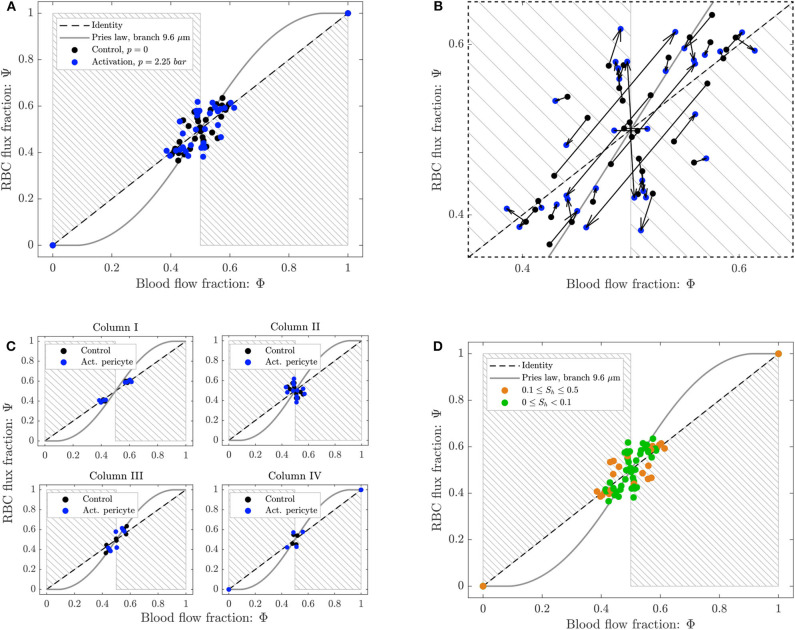
Phase separation results for pericyte activation. (A) Blood flow fraction vs. RBC flux fraction for the control case (black, ΔP = 9.8 mbar, p = 0 bar) and the inflation of the pressure chamber (blue, ΔP = 9.8 mbar, p = 2.25 bar). (B) Magnified region of (A). The arrows indicate the change of the phase separation for each bifurcation. (C) Phase separation data shown in (A) grouped with respect to column ordering defined in Figure 2. (D) Phase separation data shown in (A) grouped in function of the skewness factor of the hematocrit profile in the parent vessel of each bifurcation. For all plots circles represent data from this study. The gray continuous line is the empirical law from Pries and Secomb (2008). The dashed line is the identity line representing the proportional separation of blood and RBCs (no phase separation). Data points in the gray shaded regions indicate an inversion of the Zweifach-Fung effect (Clavica et al., 2016; Shen et al., 2016).